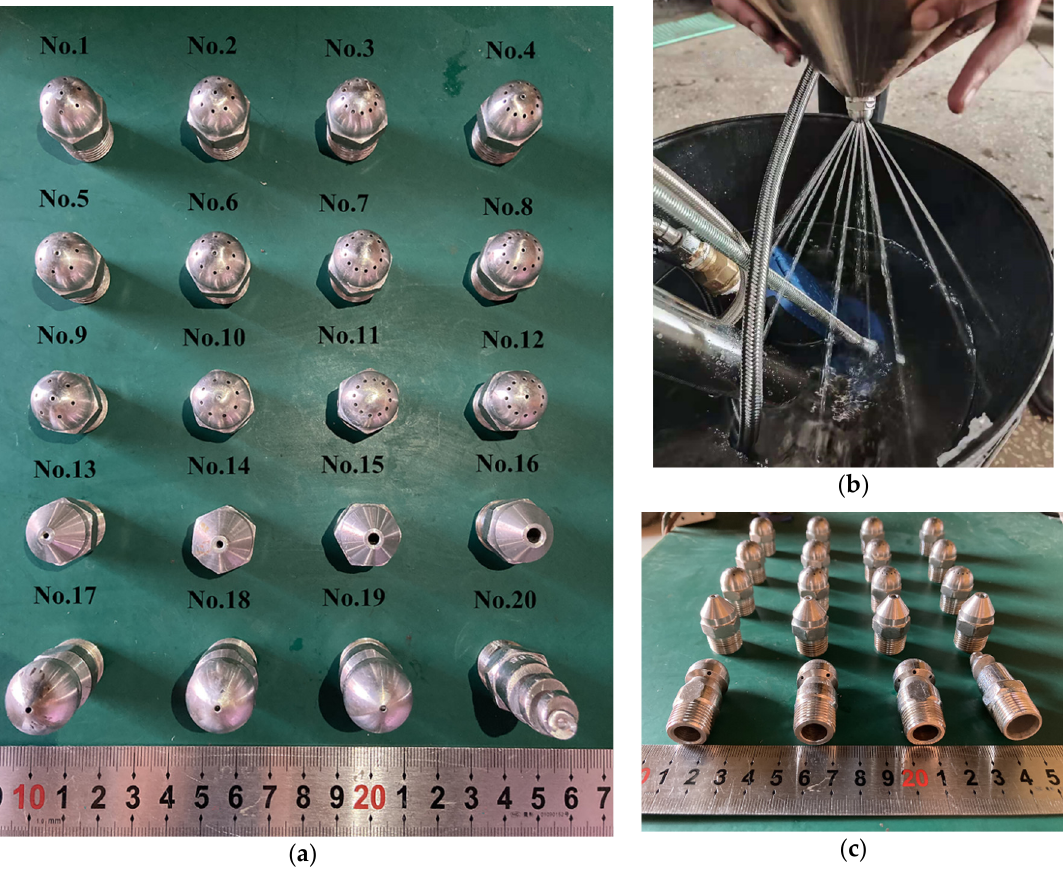
Figure 5. Nozzles used in the experiments: ( a ) photograph showing all tested nozzles; ( b ) water jet shape of the nozzle #13; ( c ) photograph showing the backward orifices in the nozzles. Table 2. Structural parameters of the nozzles used in the experiments.